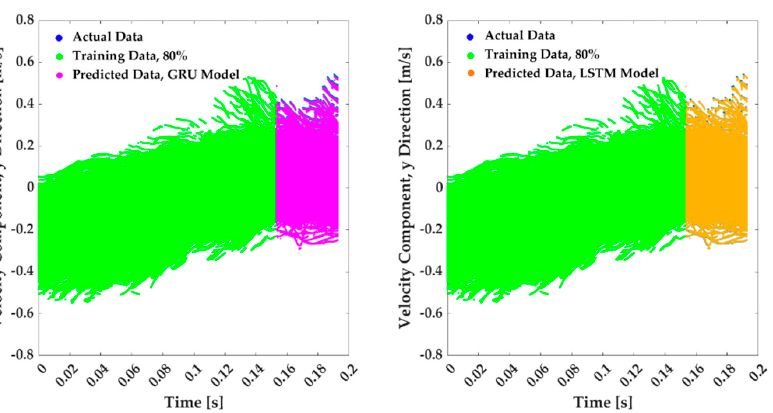
Figure 7. Prediction of velocity component in the y direction for a strained turbulent flow with mean strain rate 8 s − 1 , GRU model on the left ‐ hand side, and LSTM model on the right ‐ hand side. Training data are 80% and test data 20%.